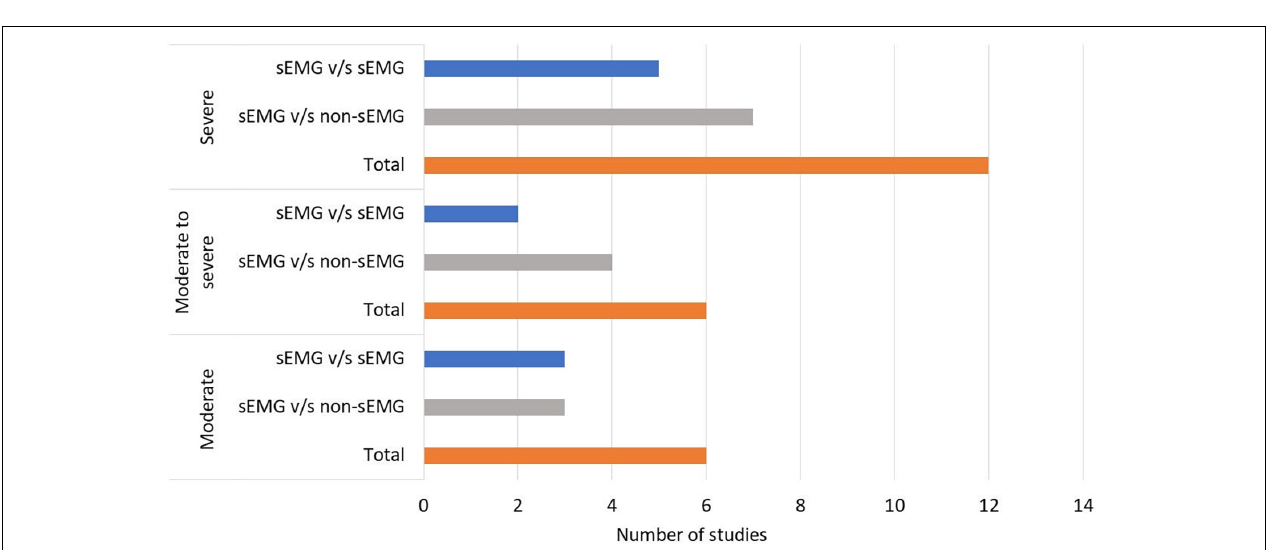
FIGURE 3 | Number of studies performed in patients with moderate to severe upper limb impairment. s-EMG v/s sEMG, studies comparing different surface electromyography driven interventions; s-EMG v/s non-sEMG, studies comparing surface electromyography driven interventions with non-surface electromyography driven